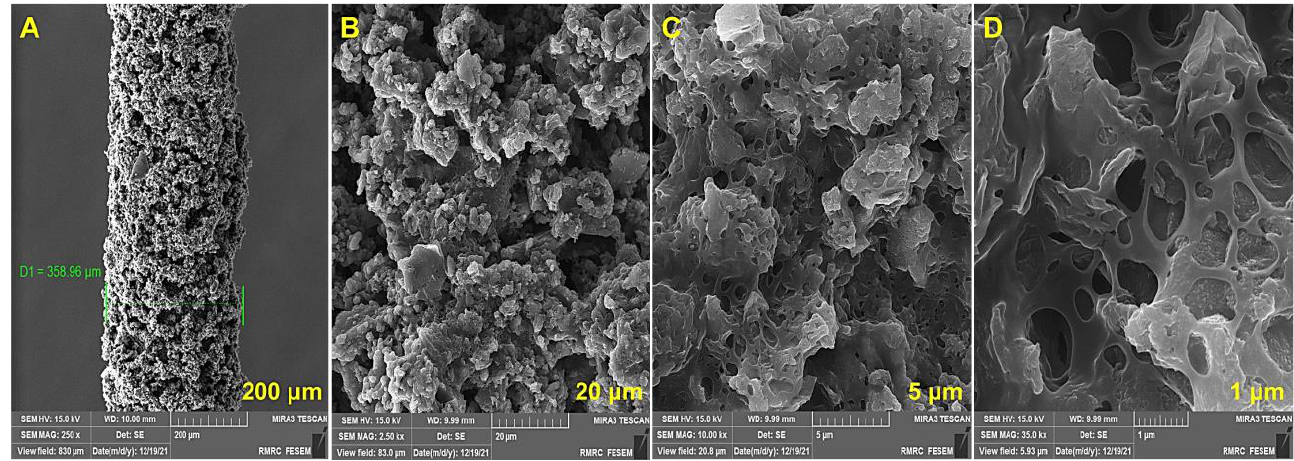
Figure 3. FE-SEM images of PEDOT-GO nanocomposite.